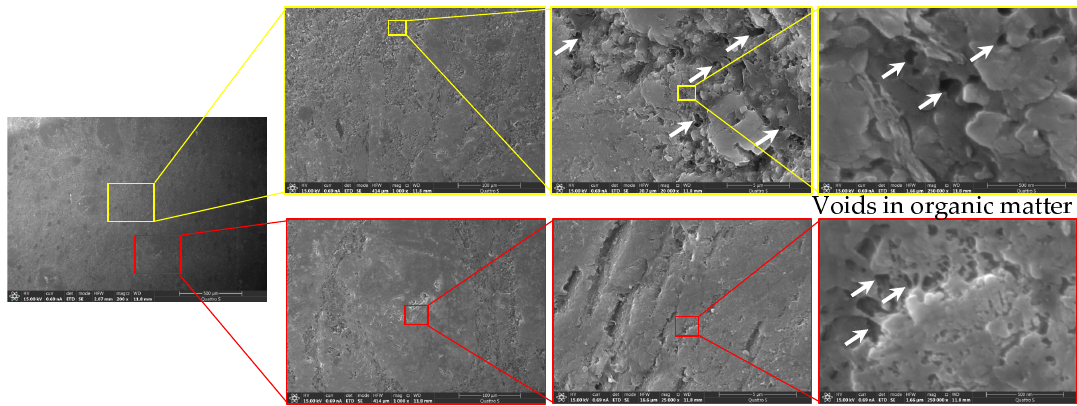
Figure 11. SEM images for sample #551-1 (white arrows indicate